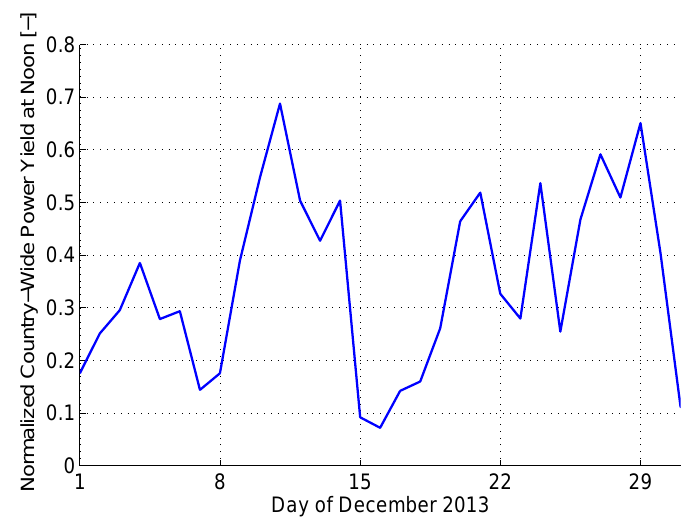
Figure 3. Proportion of renewables generated power in Germany, December 2013.